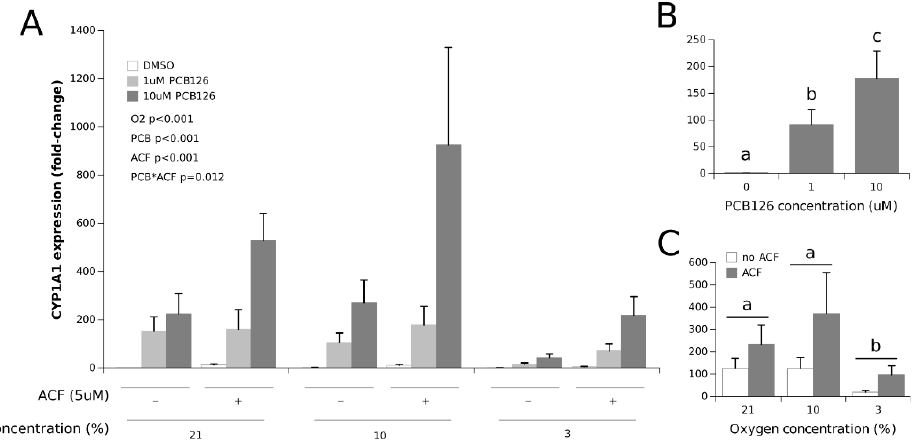
Figure 1. Effect of PCB126 and hypoxia on CYP1A1 expression in human adipocytes. Adipocytes were treated with DMSO (vector) or 1 and 10 µM PCB126 for 24 h and then subjected to 21, 10 or 3% O 2 for another 24 h. Acriflavine (ACF) 5 µM was used as an HIF 1α -inhibitor. Panel ( A ) illustrates the whole model. Markers of statistical difference for individual bars were omitted due to the complexity of the model. Panel ( B ) summarizes the main effect of PCB126 on CYP1A1 expression. Panel ( C ) summarizes the effects of hypoxia and ACF treatment on CYP1A1 expression. In panels B and C, bars or groups of bars not sharing a common letter are statistically different at p < 0.05. The letters in panel C refer to the effect of hypoxia alone, although the effect of ACF is also significant. Each bar represents the mean ± SEM of three separate experiments for each treatment group.